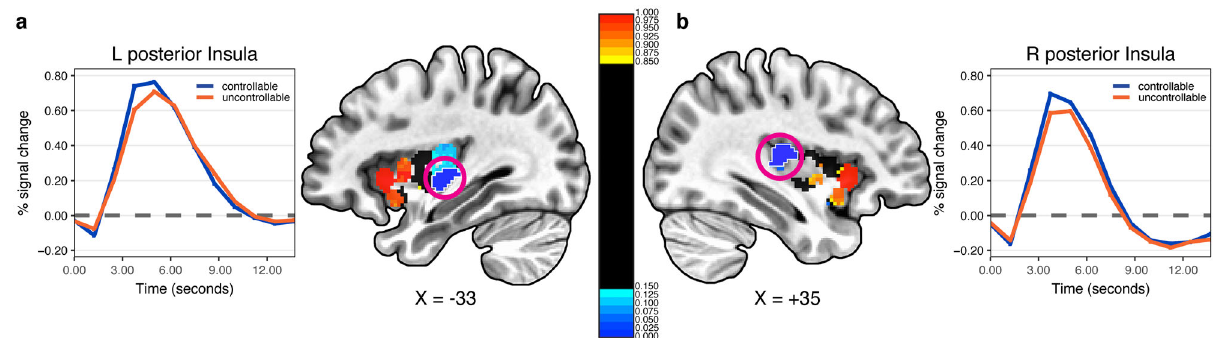
Fig. 6 Bayesian multilevel voxelwise analysis of the left (a) and right (b) insula. P + indicates the probability that uncontrollable is greater than controllable. The estimated responses for left ( a ) and right ( b ) posterior insula regions (encircled blue regions) showed strong evidence for controllable > uncontrollable ( P + values <0.05).